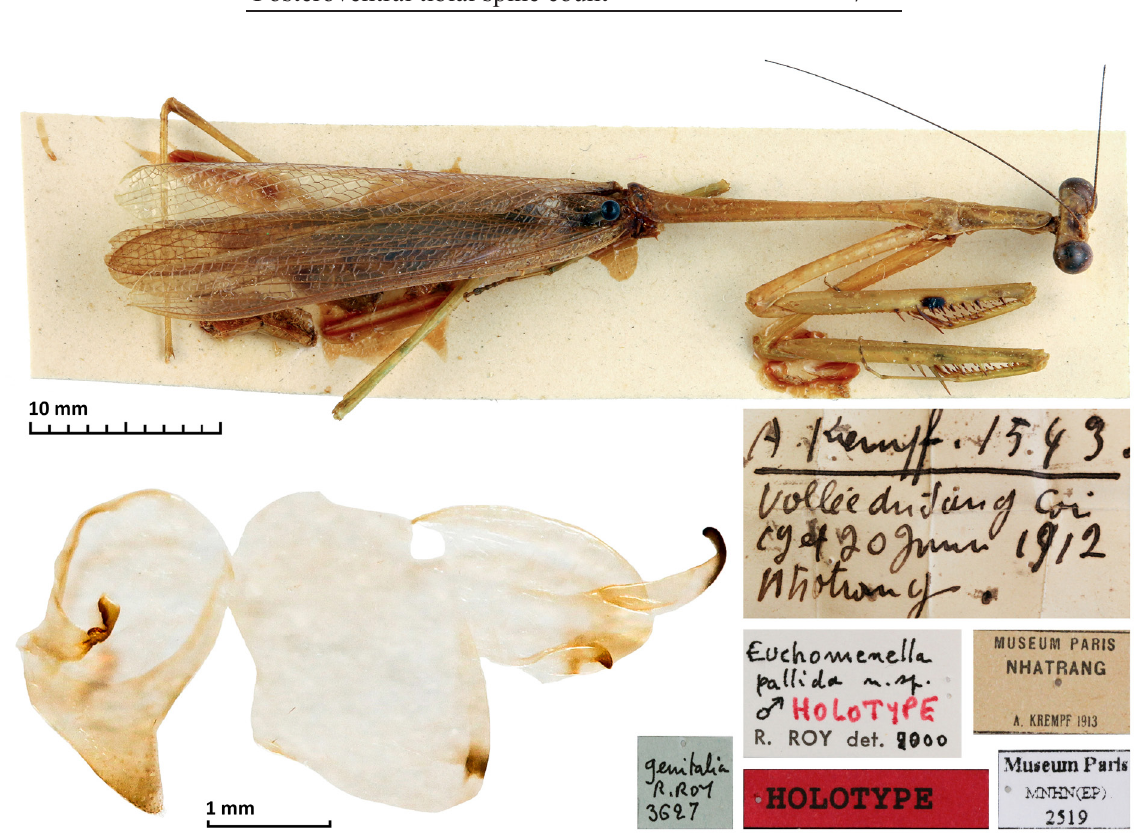
Fig. 5. Phasmomantella pallida (Roy, 2001), holotype, ♂, habitus (glued on paper), genitalia (preparation by Roger Roy nr: 3627) and labels.